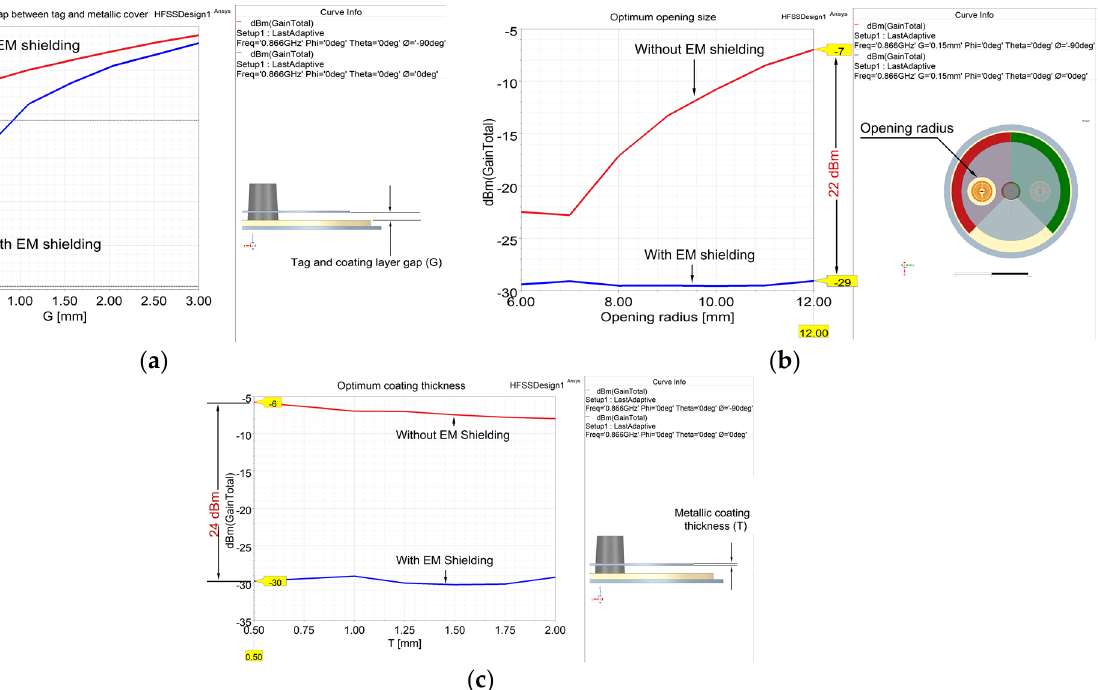
Figure 8. metallic EM shield cover tuning parameters. ( a ) The optimal point of tag and cover gap; ( b ) the optimal point of the cover opening part radius; ( c ) the Optimal point of electromagnetic cover thickness.